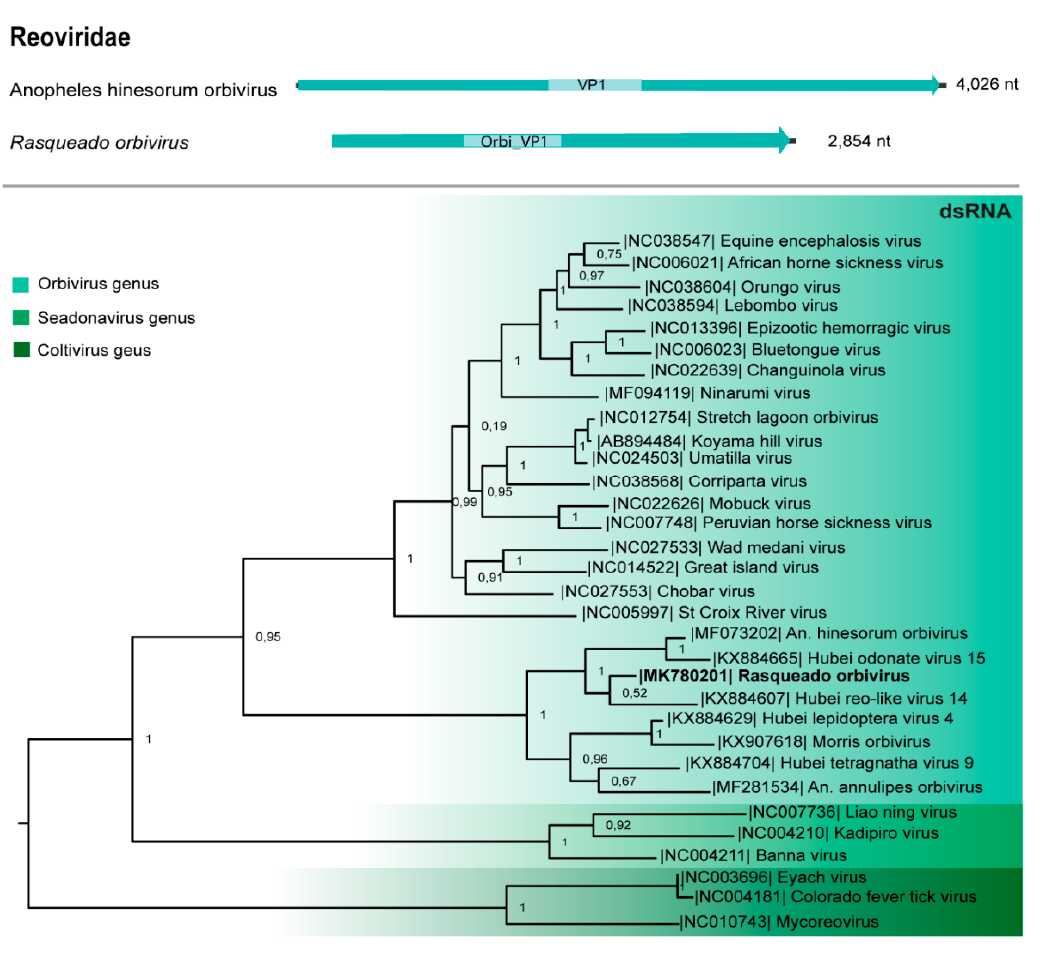
Figure 5. Genome map and maximum likelihood phylogenetic tree of Rasqueado orbivirus VP1 protein and other members of the Reoviridae family.